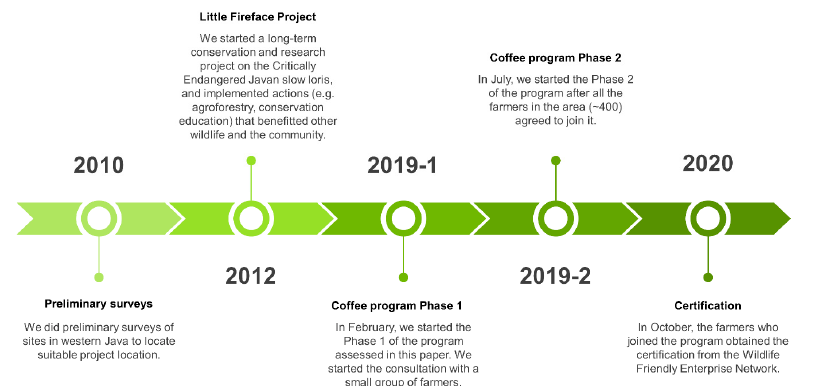
Figure 5. Timeline showing the progress of the program assessed in this paper and the background work done since 2010 (pre-consultation stage). More details are in Table 3. The coffee berry borer infestation was reduced after the implementation of the copro- duced actions (stage effect: β = –1.51 ± SE 0.22, t-value= –6.96, p < 0.001) (Figure 6). Organic plantations had significantly higher infestation than inorganic plantations (farming type